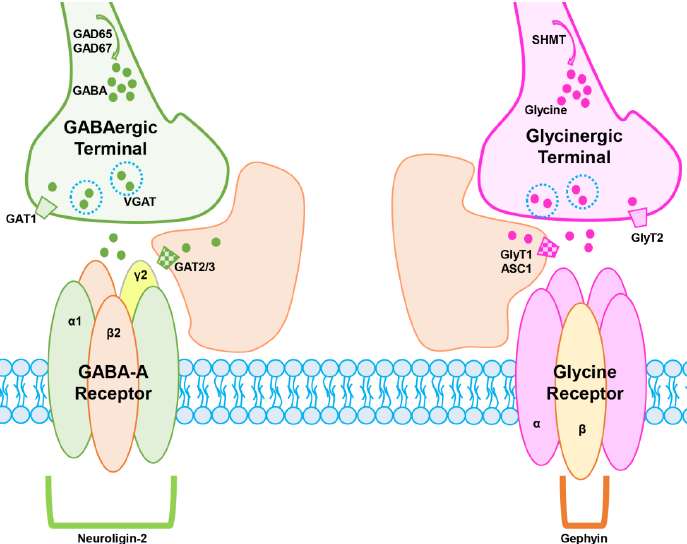
Figure 2. GABAergic and glycinergic synapses. GABA (green circles) is synthesized by GAD65 and GAD67 (green arrow) and packaged into synaptic vesicles by VGAT (blue dashed circles). Upon release into the synaptic cleft, GABA is bound by αβ subunit binding sites (green and orange subunits) at GABA-A receptors. γ subunits (yellow) provide the binding sites for modulators such as benzodiazepines. Following release into the synaptic cleft, GABA reuptake occurs presynaptically via GAT1 (green rhomboid) and in astrocytes (orange) via GAT2/3 (checked green rhomboid). GABA-A receptors are structurally maintained by Neuroligin-2 (green bracket). Glycine (pink circles) is synthesized by serine hydroxymethyltransferase (SHMT—pink arrow) and packaged into synaptic vesicles by VGAT. Upon release into the synaptic cleft glycine is bound by α subunit binding sites (pink subunits) at glycine receptors. Following release into the synaptic cleft, Glycine reuptake occurs presynaptically via GlyT2 (pink rhomboid) and in astrocytes via GlyT1/ASC1 (checked pink rhomboid). β glycine receptor subunits (peach) provide the binding sites for gephyrin (orange bracket) in order to structurally maintain the